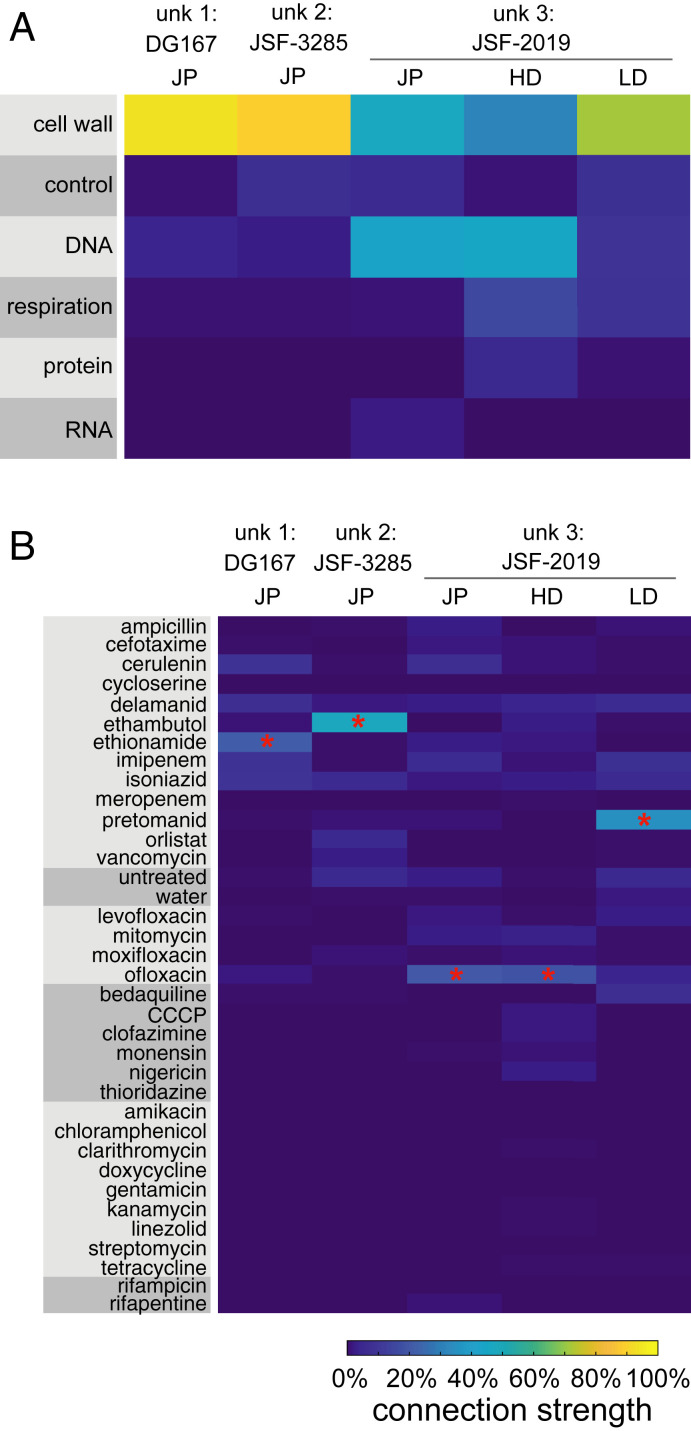
MorphEUS accurately predicts pathways of action of compounds when blinded to mechanism of action. (A) cKNN profiles of broad drug categories and (B) individual drugs for compounds with anti-TB activities (unk, unknown). Each column corresponds to a different compound or treatment dose. From left to right, joint dose profile (JP) for DG167, JSF-3825, JSF-2019; high dose profile (HD) for JSF-2019; and low dose (LD) profile for JSF-2019: n = 7,300, 7,160, 7,742, 7,742, 5,150, and 2,592 respectively. The most similar drug for each MorphEUS classification is indicated by the red asterisk.